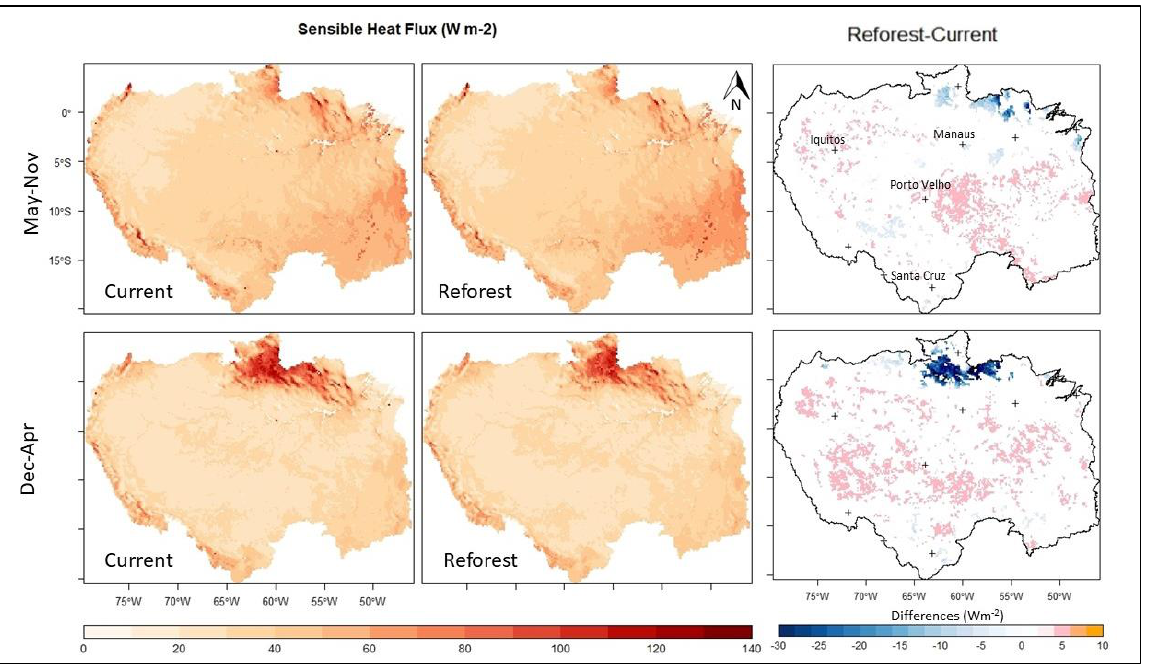
Figure 5. Simulated SH, forced with current and reforested land cover on the left. On the right, the difference between the two simulated SHs at a 95% significance level. Plus signs indicate major cities.